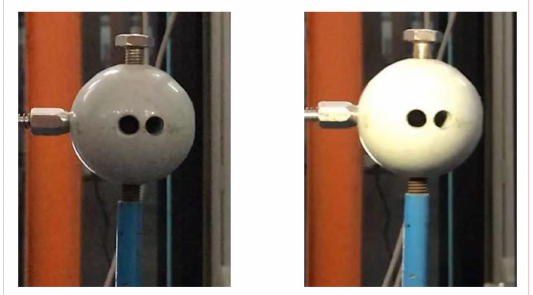
Figure 10. Comparison of variable illumination.